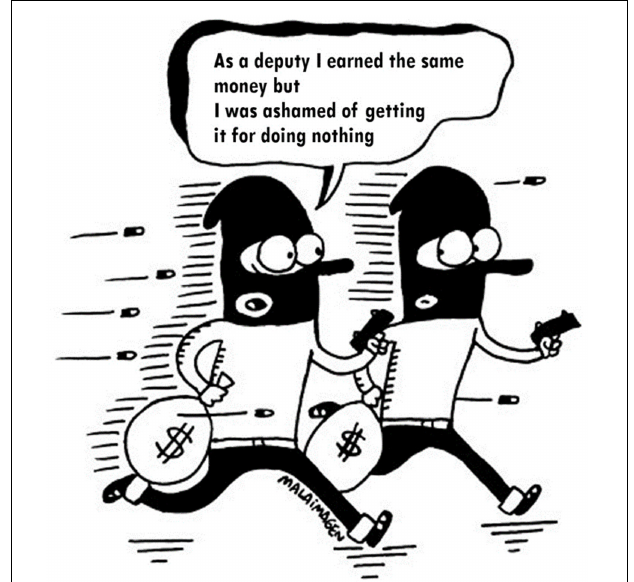
FIGURE 2 | Example of cartoon used for study